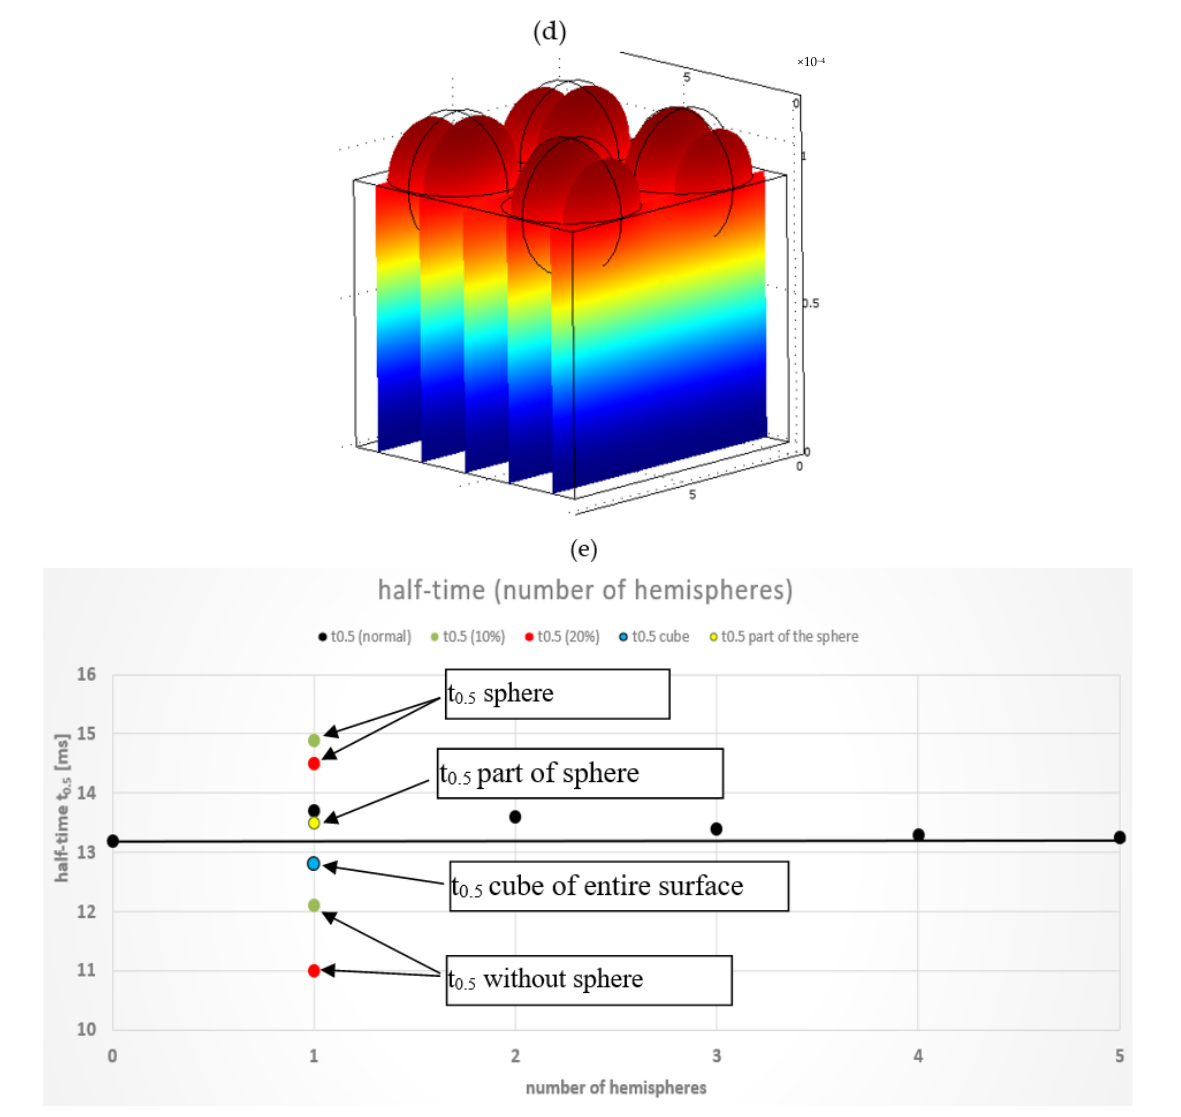
Figure 6. Distribution of temperature rise on the rear surface of the samples: ( a ) flat surface (without sphere), ( b ) spherical surface, ( c ) temperature distribution in selected characteristic points in the model, ( d ) example of temperature distribution in the sample after a laser shot, ( e ) half-life for different variants tested numerically.